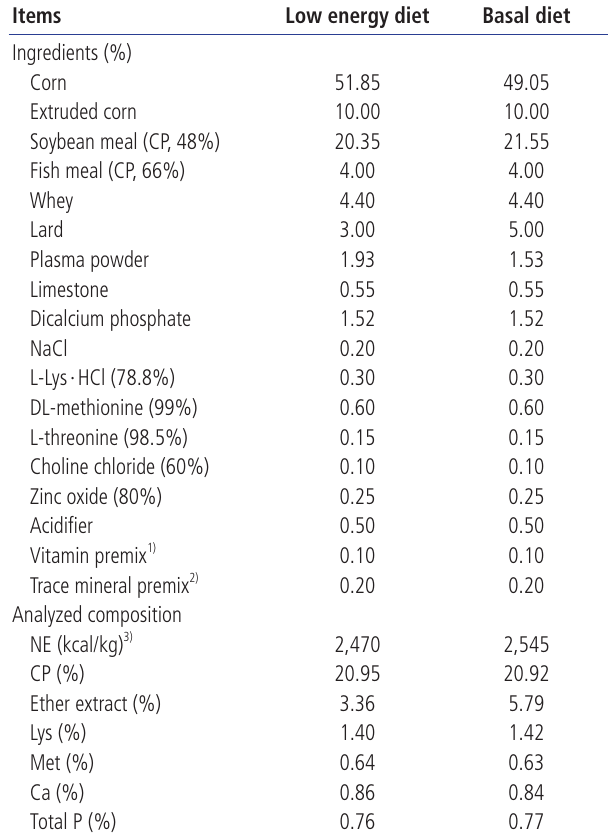
Table 1. Diet composition (as-fed